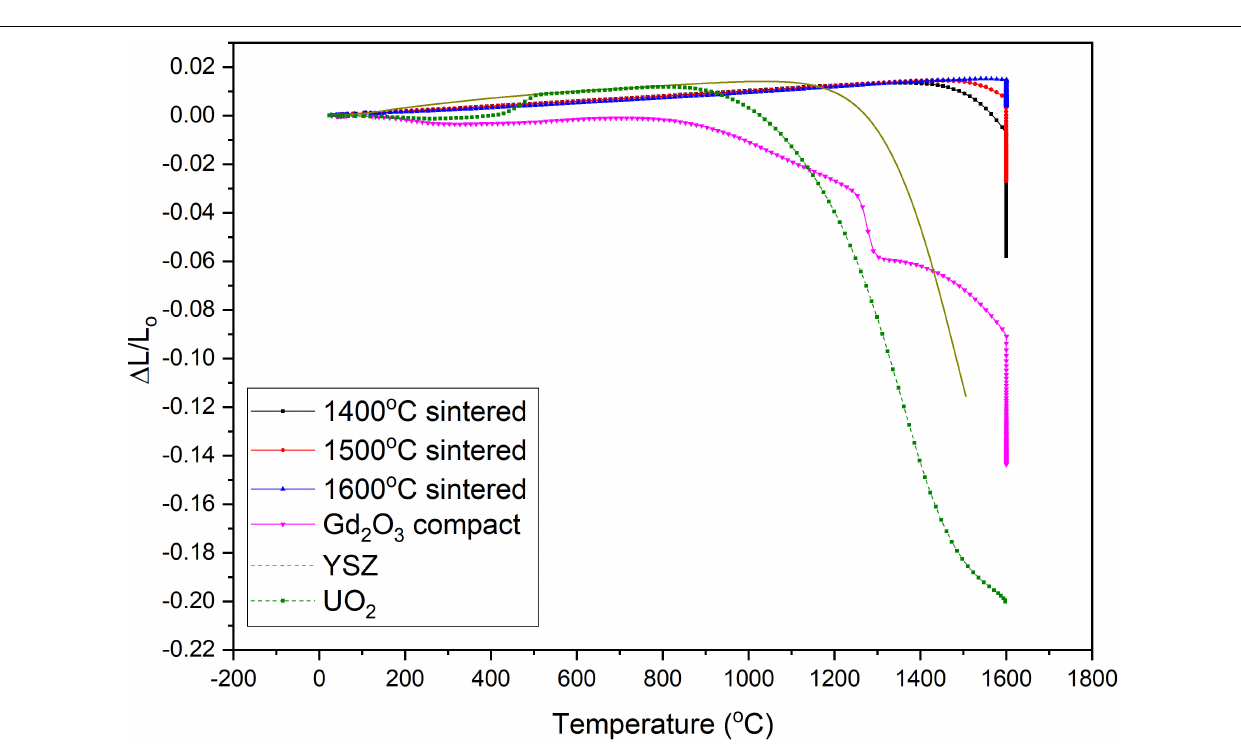
Frontiers in Energy Research |